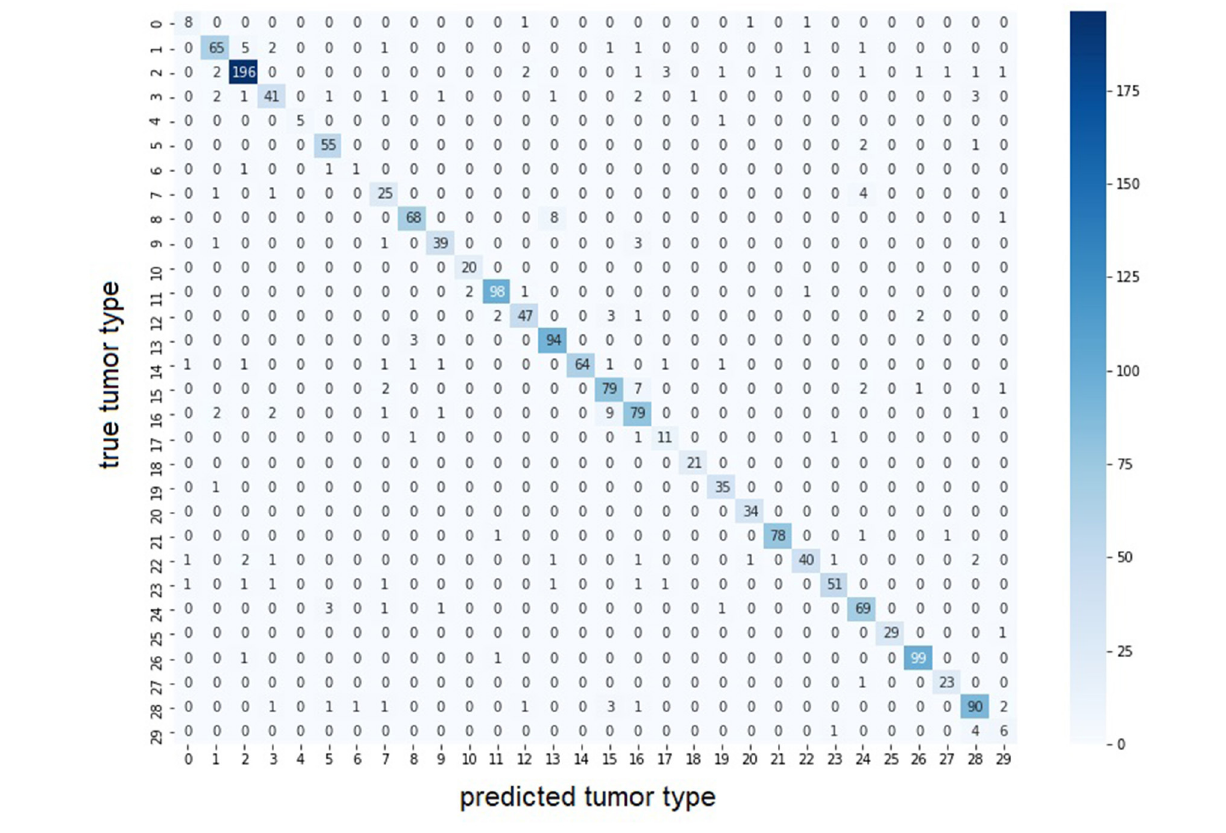
Frontiers in Public Health |